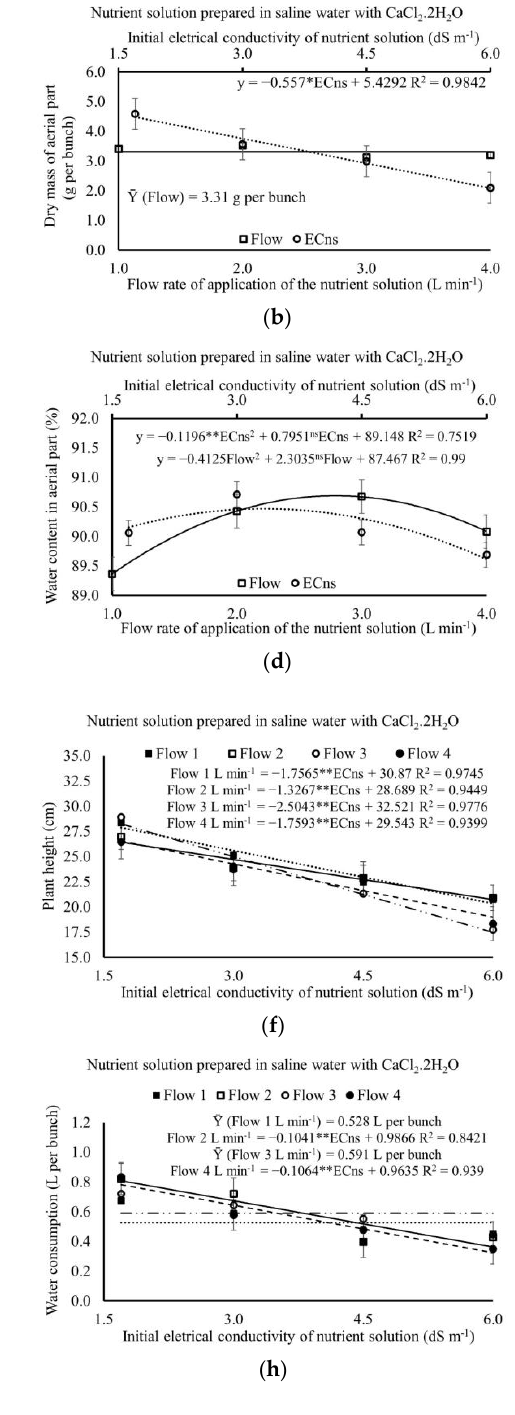
total water consumption ( g , h ) of coriander plants, cv. Verd ã o, exposed to nutrient solutions prepared pared in brackish water, salinized with NaCl and CaCl 2 ·2H 2 O, and applied in crescent flow rates.